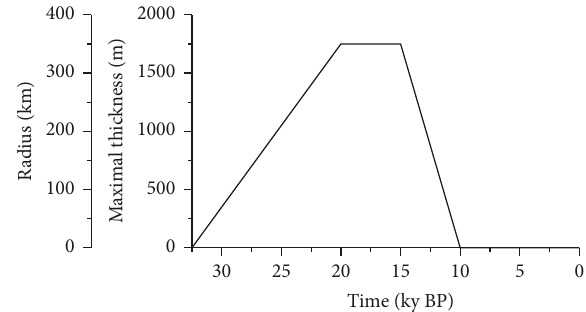
Figure 2: Glaciation scenario: variation of the ice-sheet radius and maximum thickness over